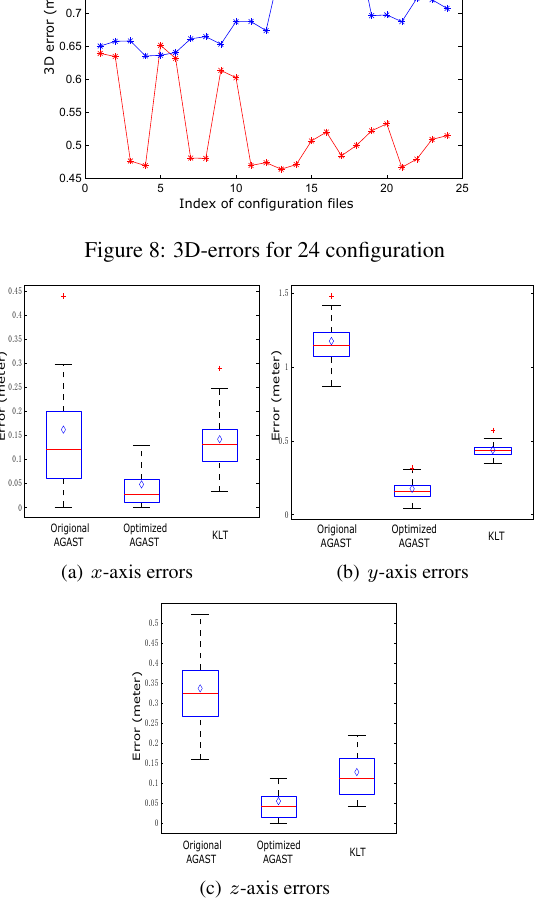
(c) z -axis errors Figure 9: Box plots of 50 testing results. The upper and lower edges of the boxes are the 25th and 75th percentiles, the red crosses are the outliers, the diamonds are the RMS